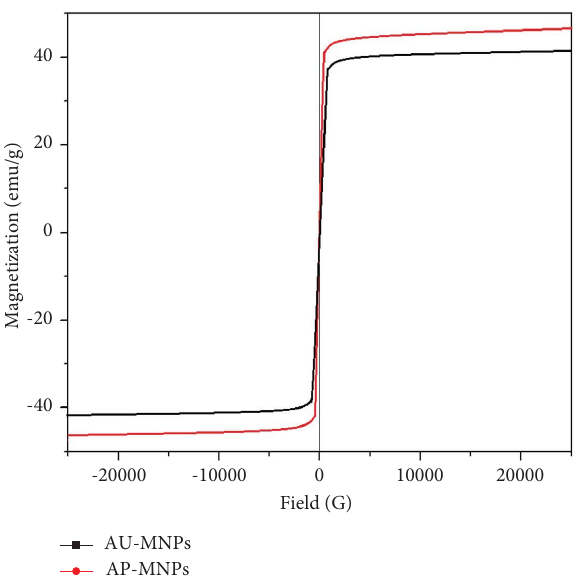
Figure 8: Loop of AU-MNPs and AP-MNPs.